Question: Produce a descriptive caption suitable for publication.
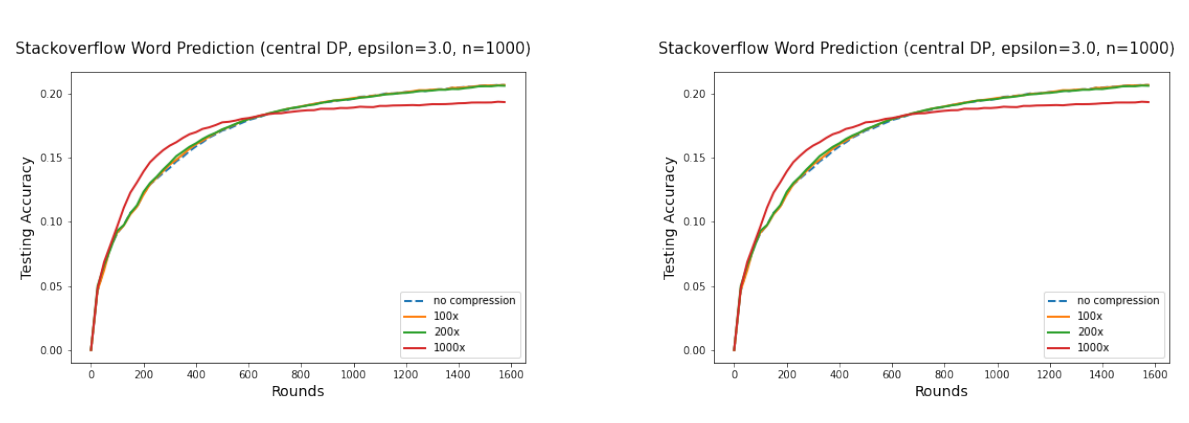
Answer: Accuracy of GM and CSGM, with δ = 10−5 and cohort size 100. The ∆∞/∆2 ratio is 6.4 · 10−3